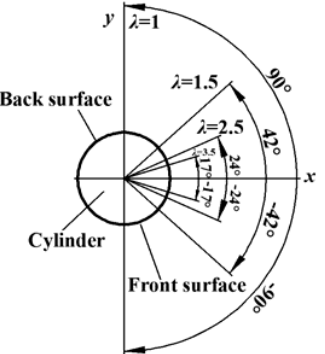
Figure 21. Ranges of the inflow angle under high TSR conditions.